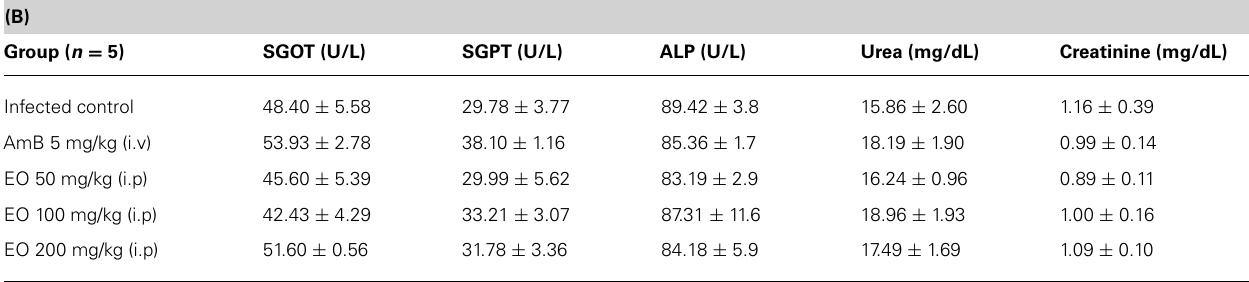
Table 2 | (A) Effect of AALEO on hepatic and renal functions of normal BALB/c mice. (B) Effect of AALEO on hepatic and renal functions of infected BALB/c mice post-treatment. (A) Group ( n = 5) SGOT (U/L) SGPT (U/L) ALP (U/L) Urea (mg/dL) Control Essential oils (EO) 200 mg/kg (i.p)